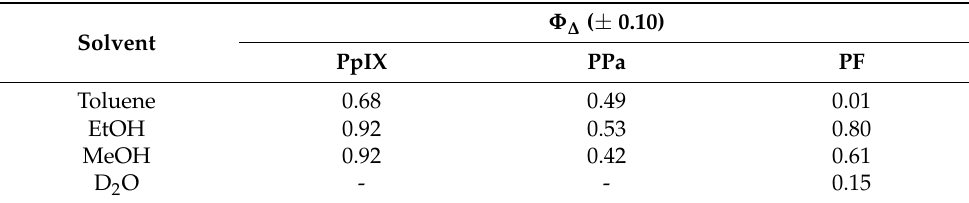
Table 5. Φ ∆ of PpIX, PPa, and PF in different solvents at room temperature ( c = 1.87 µ M). Φ ∆ ( ± 0.10) Solvent PpIX PPa PF Toluene 0.68 0.49 0.01 EtOH 0.92 0.53 0.80 MeOH 0.92 0.42